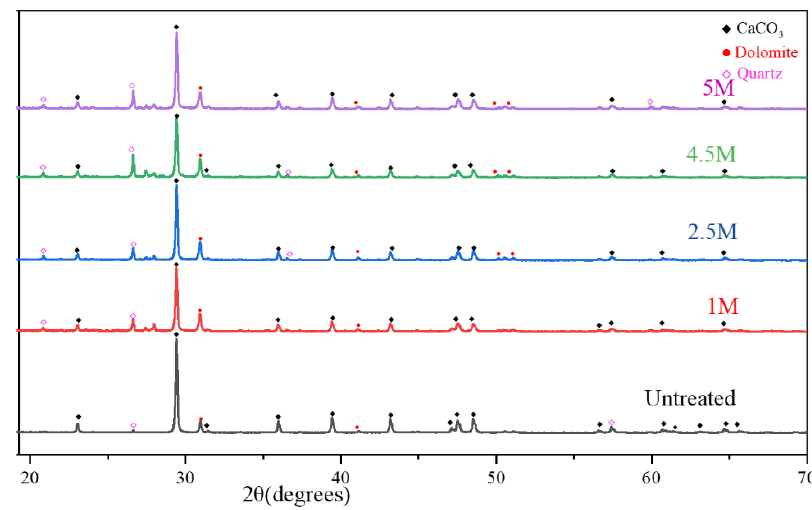
Figure 4. XRD pattern of samples treated with